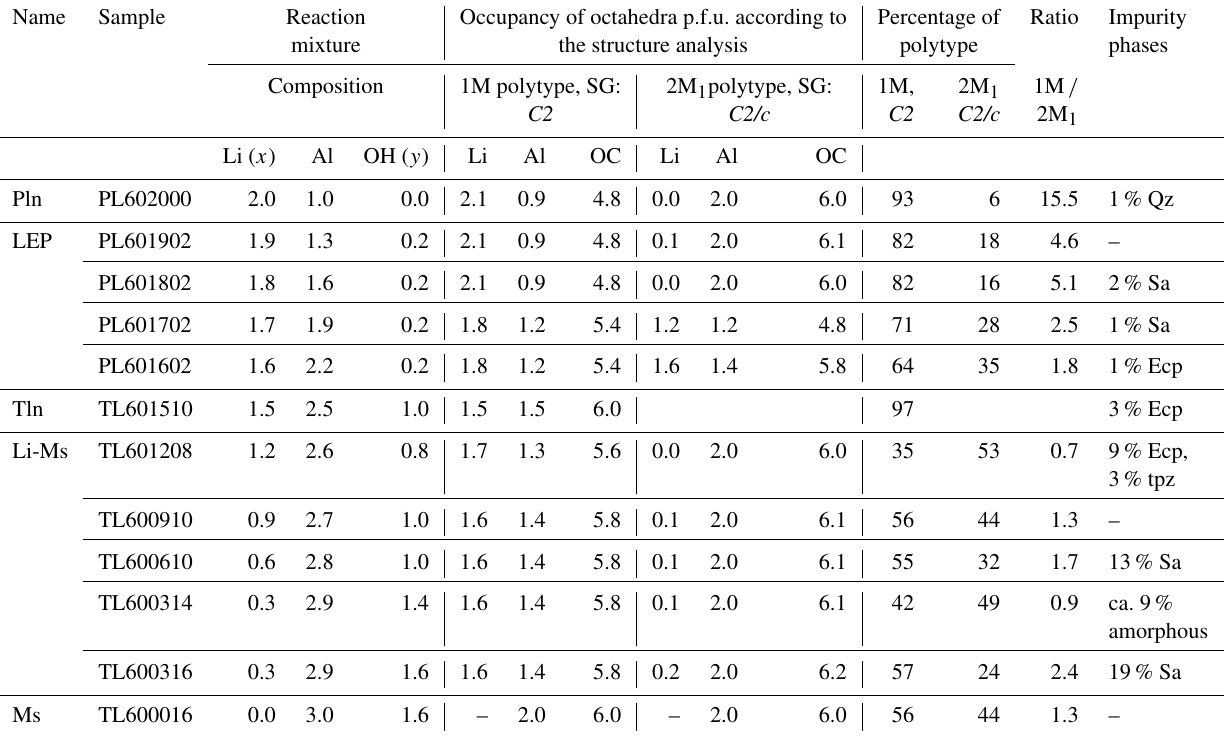
Table 4. Results of the Rietveld refinements. OC: total charge of the three octahedral sites, SG: space group, p.f.u.: per formula unit, Qz: SiO 2 (quartz), Ecp: eucryptite, Sa: sanidine, Pln: polylithionite, Tln: trilithionite, LEP: lepidolite, Ms: muscovite, Li-Ms: lithium muscovite, tpz: